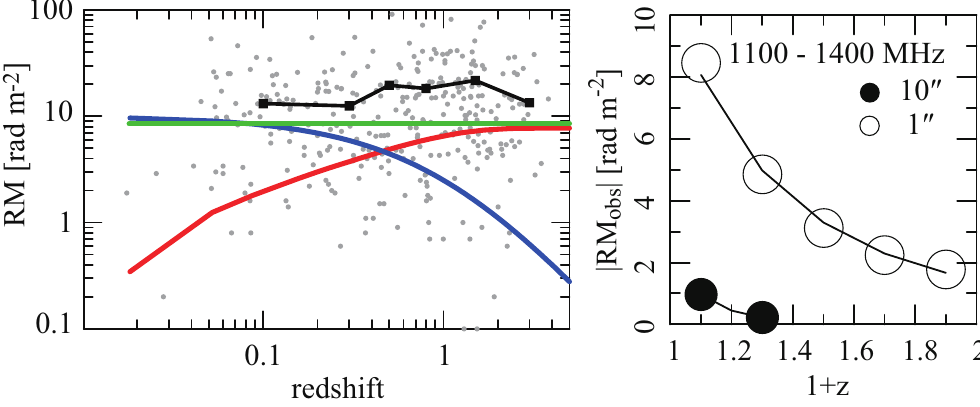
Figure 2. ( Left ) RM as a function of redshift [42]. Gray filled circles show the observed RMs of 317 sources located at high galactic latitudes, | b | > 75 ◦ . The black line indicates the standard deviation of error-subtracted RMs (see the text). The blue line shows a baseline scenario for the standard deviation of the intrinsic RM, σ INT = 10 ( 1 + z ) − 2 rad m − 2 . The red line shows the standard deviation of the WHIM’s RM in the TS0 run (Figure 1 right). The green line shows the standard deviation of the observed Milky Way contribution σ ISM = 8.4 rad m − 2 toward high galactic latitudes. ( Right ) Simulated RM caused by a depolarizing intervening galaxy (DING). RM is derived from the linear fit for polarization angles from 1100 MHz–1400 MHz. The open and filled circles show the results with the sizes of background sources, 1 (cid:48)(cid:48) and 10 (cid:48)(cid:48) ,